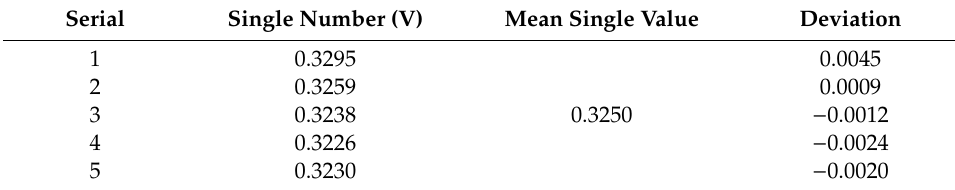
Figure 8. Spot images of serum reaction. Table 3. Light reflection signal values of dry chemical diagnostic reagents in